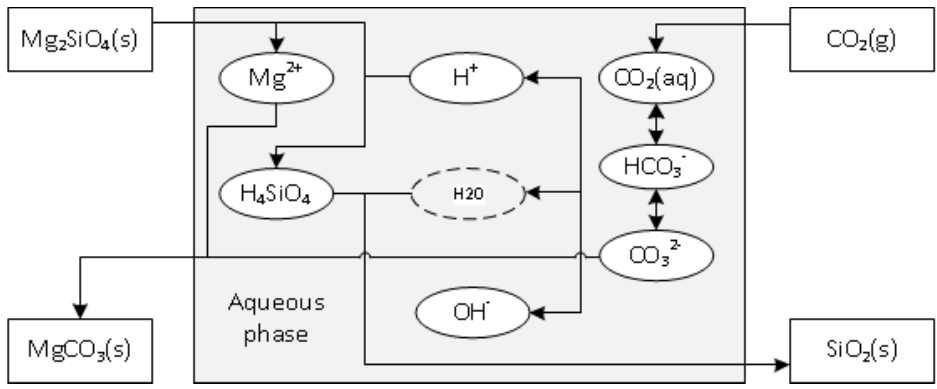
Figure 1. Reaction path of direct forsterite carbonation in the aqueous